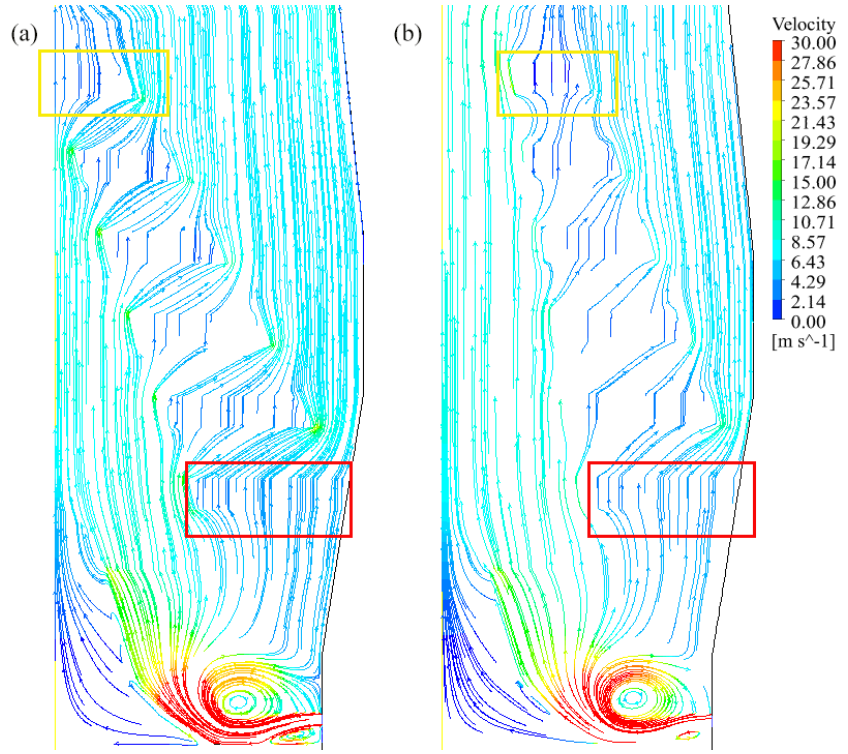
Figure 6. Path line of cohesive zone in a traditional BF (R = 50%, γ = 60 ◦ , n = 6): ( a ) without central coke; ( b ) with central coke.